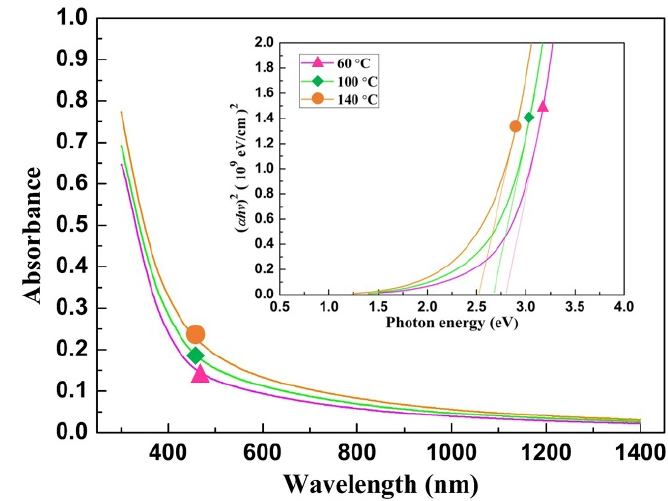
Figure 5. Absorbances and optical band gaps (inset) of the amorphous SnS 2 films fabricated at different temperatures. The absorbance increased with the growth temperature, and the optical band gaps of the amorphous SnS 2 were 2.80, 2.68, and 2.52 eV at 60, 100, and 140 °C, respectively. Table 1. The summaries of crystal structure and optical band gap for each deposition temperature.